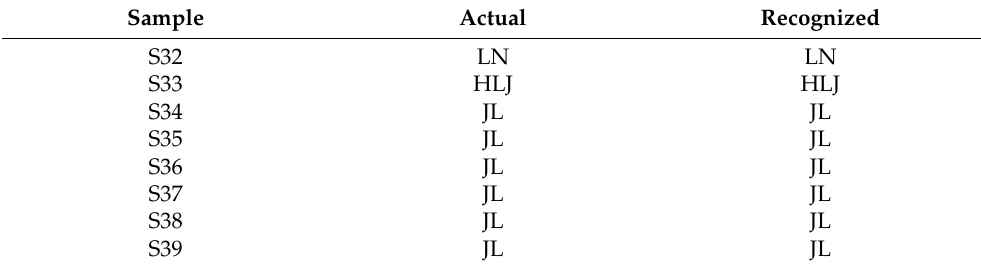
Table 3. The classified and predicted results of ginseng test samples from three different geographical origins using SVM model with raw data and normalized data. Sample Actual Recognized